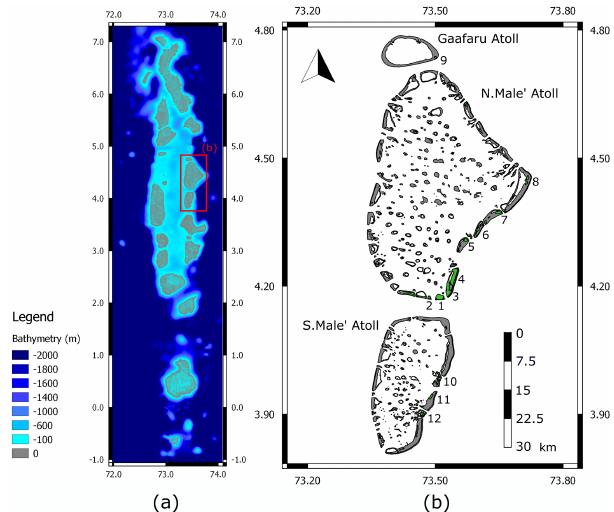
Figure 1. (a) Bathymetry of the Maldives archipelago as per Rasheed et al. (2021). (b) The study region which includes the atolls of Gaafaru atoll, North Malé atoll and South Malé atoll with the shallow water lagoons (grey) and islands (green) marked. Inhabited islands, excluding industrial islands, are labelled as (1) Malé, (2) Villingilli, (3) Hulhulé, (4) Hulhumalé, (5) Him- mafushi, (6) Huraa, (7) Thulusdhoo, (8) Dhiffushi, (9) Gaafaru, (10) Gulhi, (11) Maafushi, (12) Guraidhoo; boundaries of lagoons based upon Spalding et al.